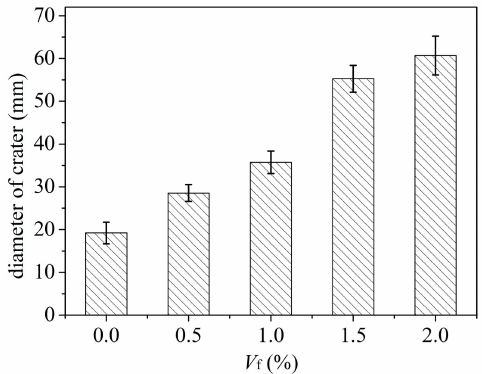
Figure 5. Influence of PVA fiber volume contents ( V f) on diameter of impact craters. Table 5. Test results of PVA-FRCM under drop weight impact